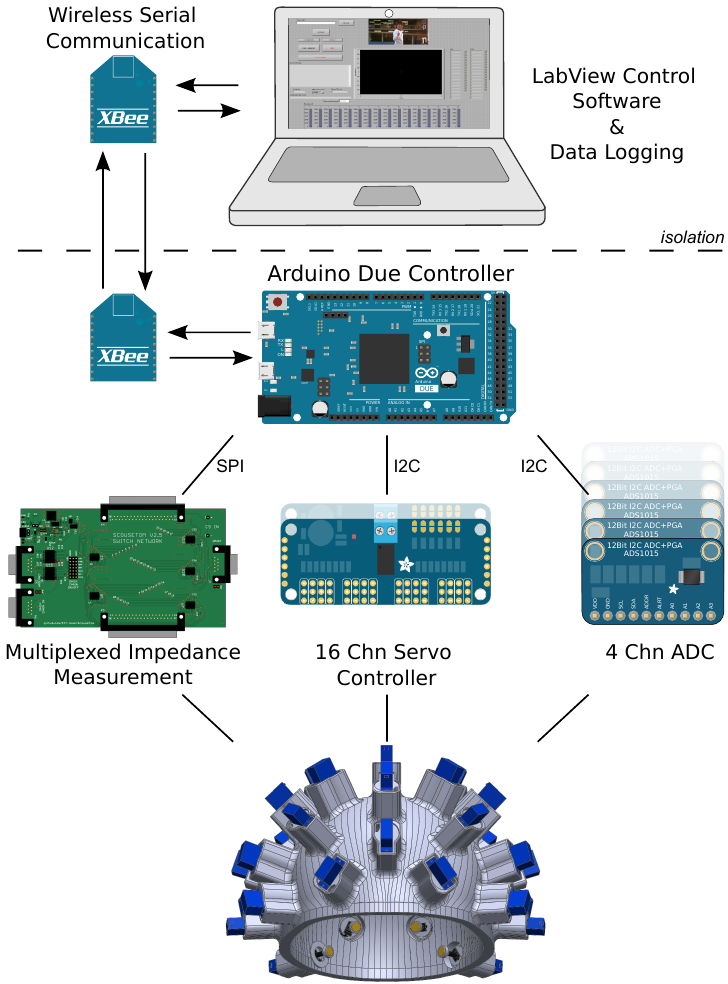
Figure 14. Overview of helmet controller. Labview software controlling Arduino Due through wireless serial communication. Ardruino controls electrode rotation, impedance and position